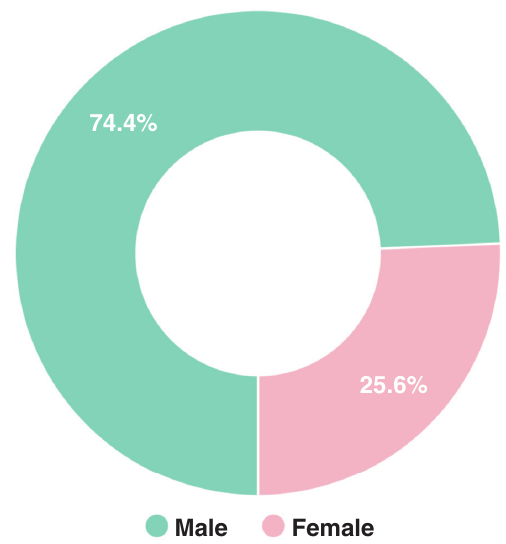
Figure 4. Gender distribution of the ASTPC contributions; reproduced from data reports obtained from the website http://